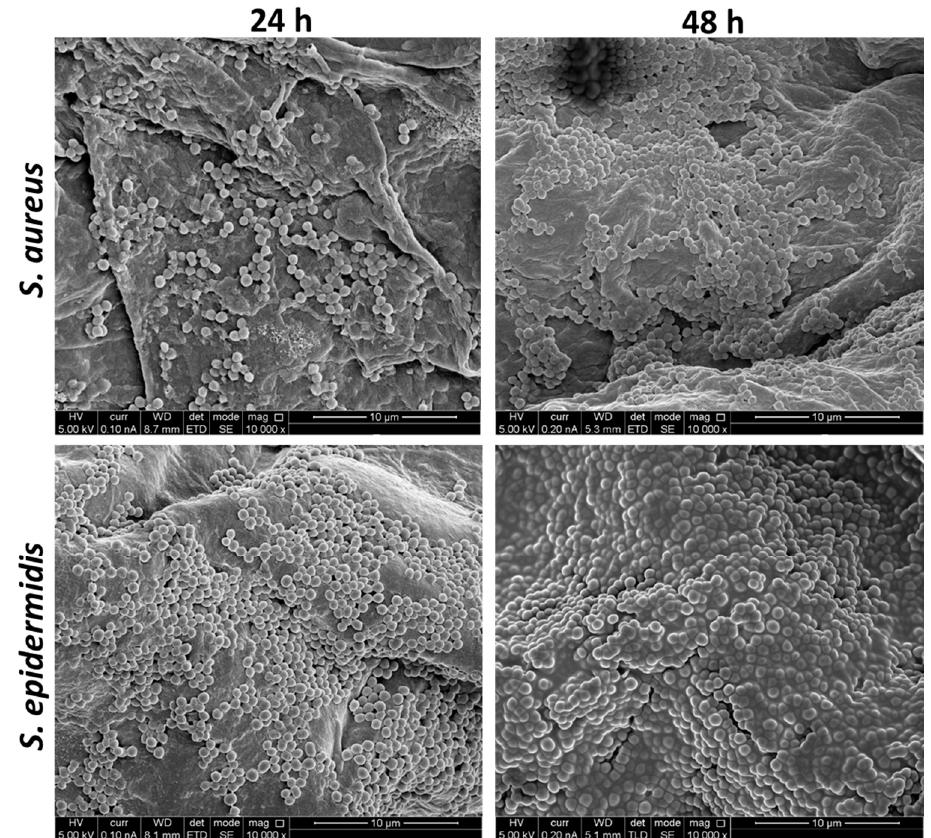
Figure 1. Scanning electron microscopy (SEM) images of ex vivo human skin that was infected with S. aureus and S. epidermidis for 24 or 48 h. Cocci-shaped bacteria appeared to adhere to the surface and become entangled in a matrix-like substance. Magnification: ×